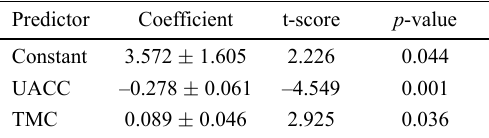
Table 1. Stepwise linear regression